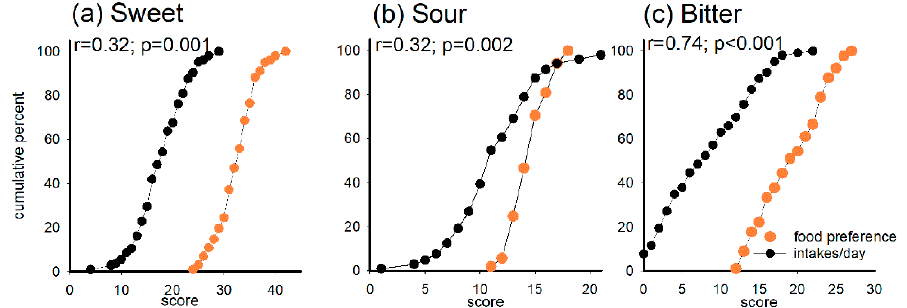
Figure 3. Cumulative percentage curves for food preference scores (orange) and consumption frequency (black) in the taste categories ( a ) sweet, ( b ) sour and ( c ) bitter. Spearman correlation coefficients ( r ) are shown at the top of each plot.